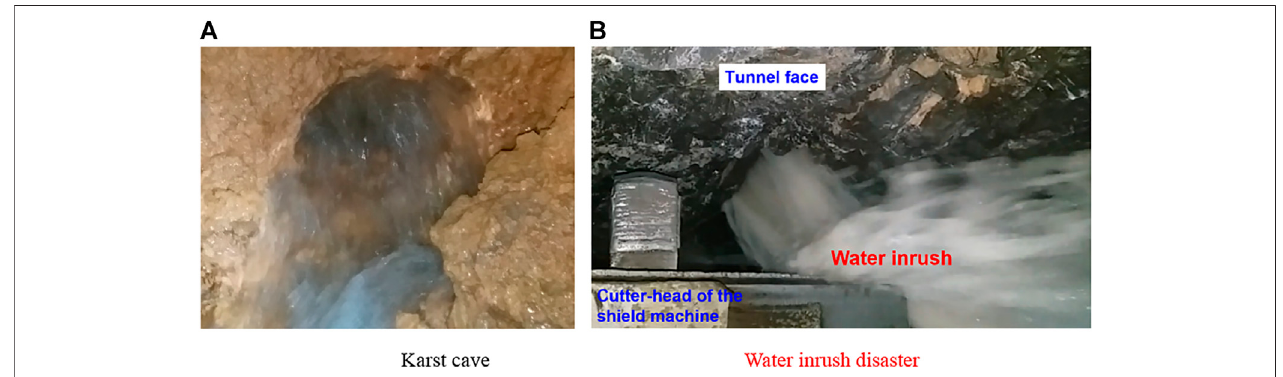
FIGURE 5 | Water inrush at the tunnel face. (A) Karst cave. (B) Water inrush disaster.